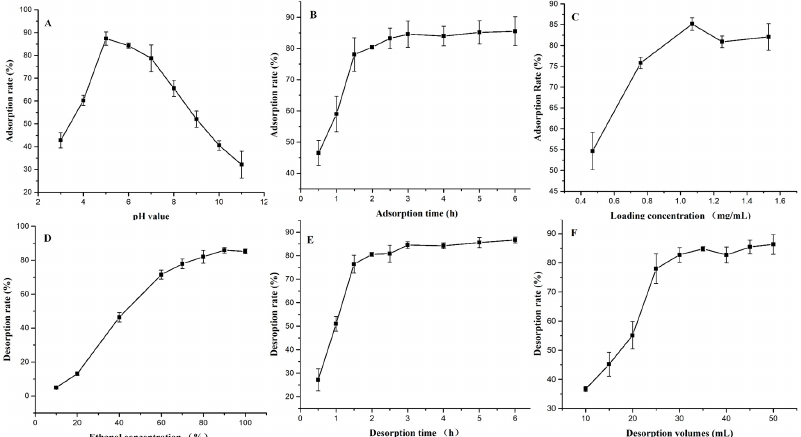
Figure 4. Results of static single-factor tests. ( A ) Effects of the pH value on the adsorption rate; ( B ) effects of the adsorption time on the adsorption rate; ( C ) effects of the loading concentration on the adsorption rate; ( D ) effects of the ethanol concentration on the desorption rate; ( E ) effects of the desorption time on the desorption rate; ( F ) effects of the desorption solution volumes on the desorption rate.